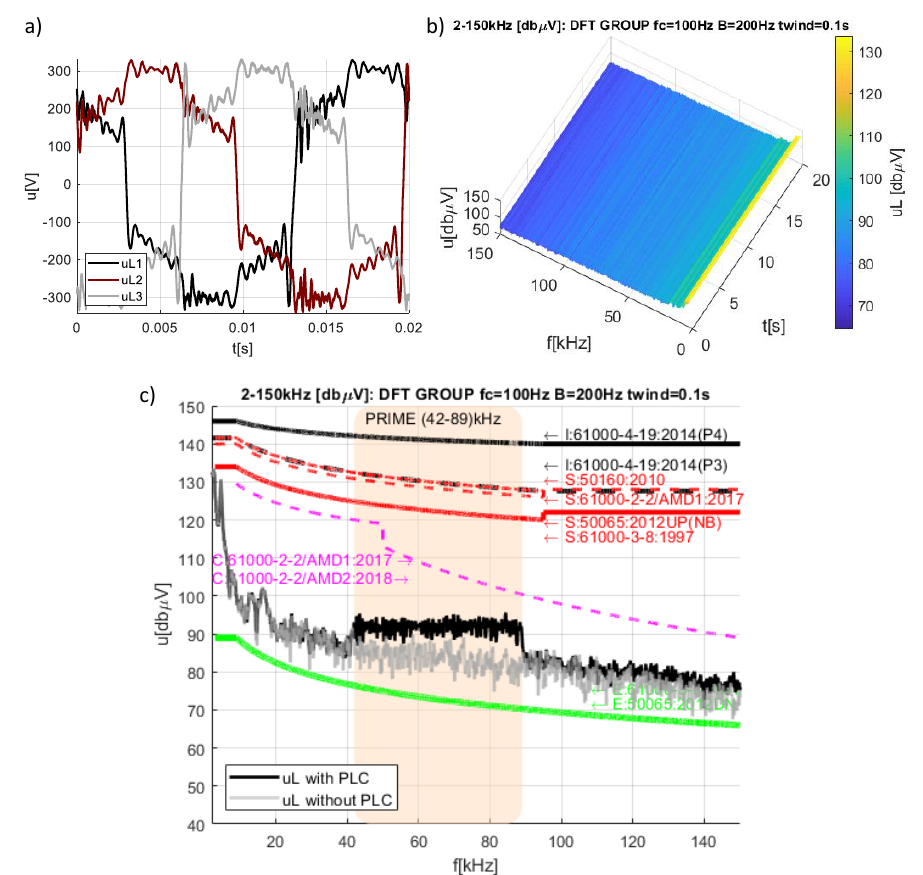
Figure 10. Case 4: results of the analysis of PRIME PLC system operation with LED light sources at distorted supply voltage referring to permissible limits for low-frequency immunity tests defined in IEC 61000-4-13 [30]; ( a ) supply voltage waveform; ( b ) time-frequency representation in the range 2–150 kHz using 100 ms window during the 20 s observation; ( c ) comparison of the spectrum of the corresponding PRIME PLC transmission (black) and the spectrum of the voltage in the connection point of the load (grey) with the relation to the normative curves (uL—line voltage in the point of the equipment connection, which is also the point of energy meter connection with PRIME PLC). Table 3. The magnitude of particular harmonics of the supply voltage used in low-frequency im- munity tests according to IEC 61000-4-13 [30] addressed to the equipment of third class of the im- munity.